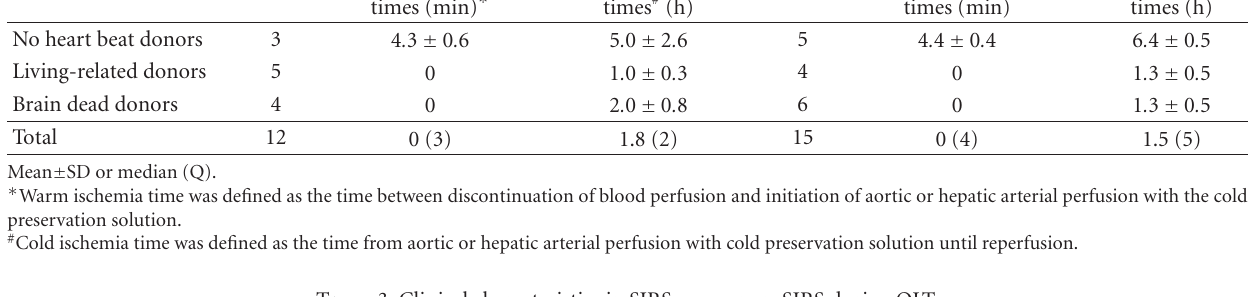
Table 3: Clinical characteristics in SIRS versus non-SIRS during